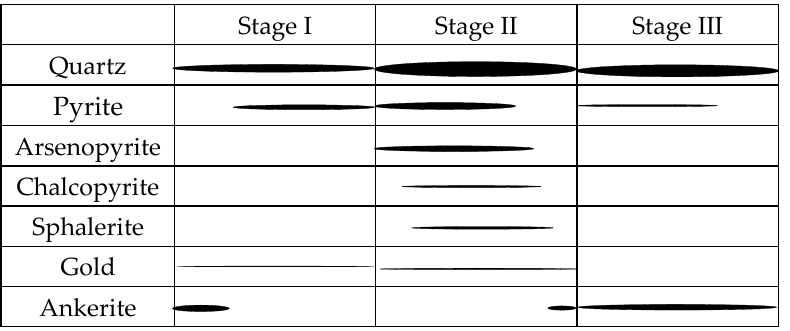
Figure 4. Mineral paragenetic sequence for the Xiaojiashan gold deposit.